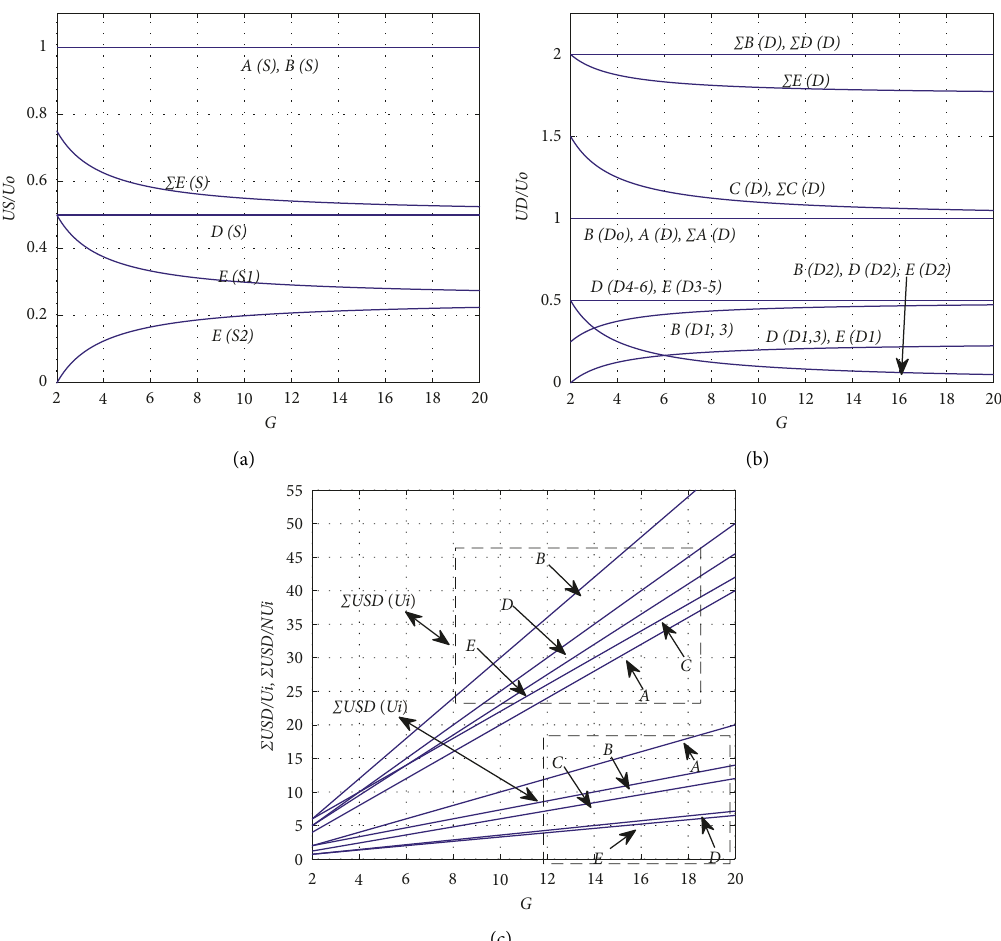
Figure 9: Comparison of voltage. (a) Switch voltages, (b) diode voltages, and (c) Σ USD / Ui and Σ USD / NUi versus voltage gain G. Note: X ( Z ) means the switch or diode of converter X , Σ X ( Z ) are total voltage of switches or diodes for converter X, and Σ VSD are total voltage stress of switches and diodes.